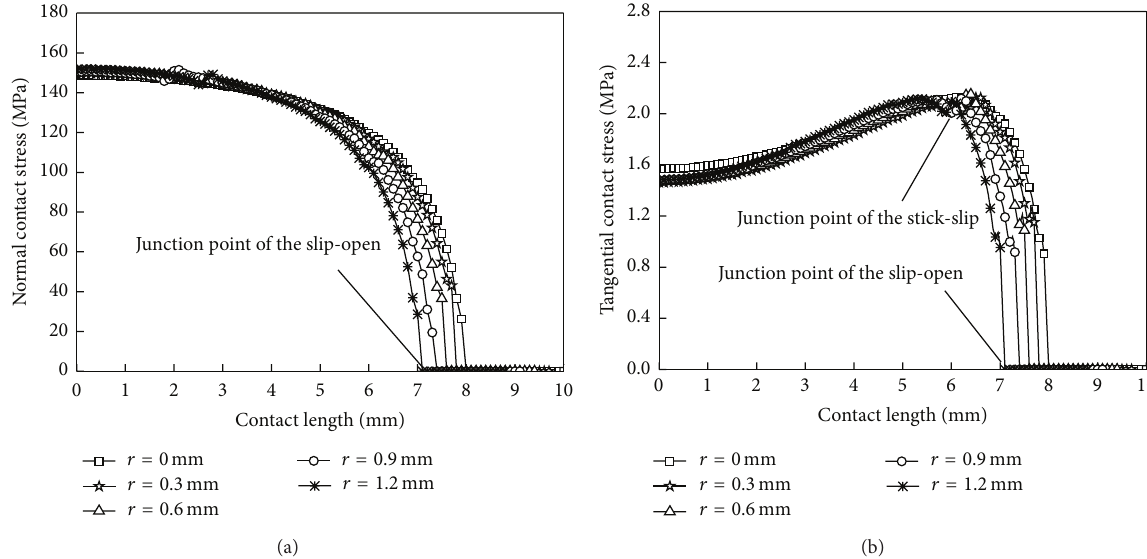
Figure 15: Contact stress distribution curves under different wear quantities. (a) Normal contact stress and (b) tangential contact